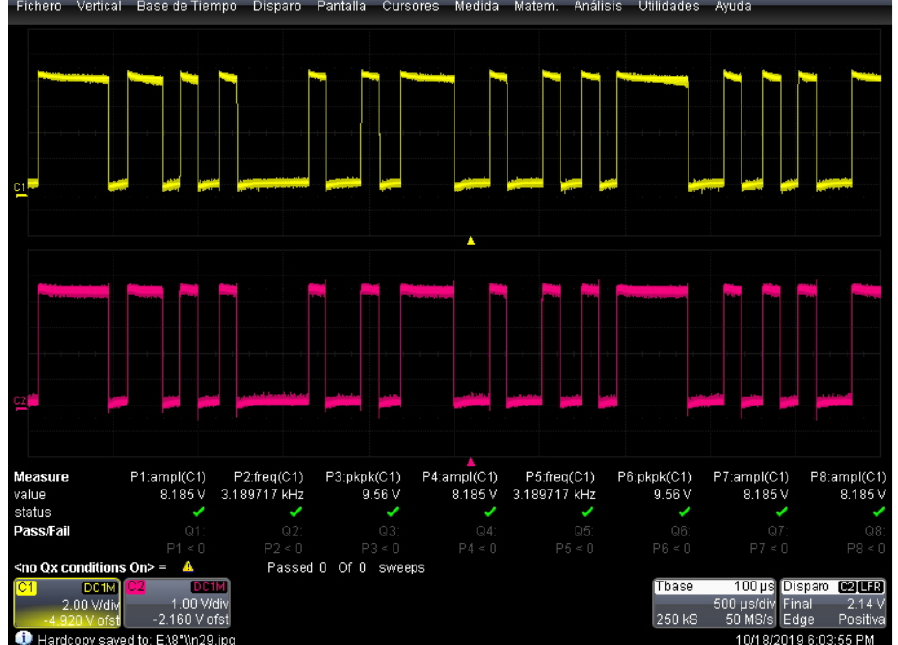
Figure 9. Comparison of emitted and received